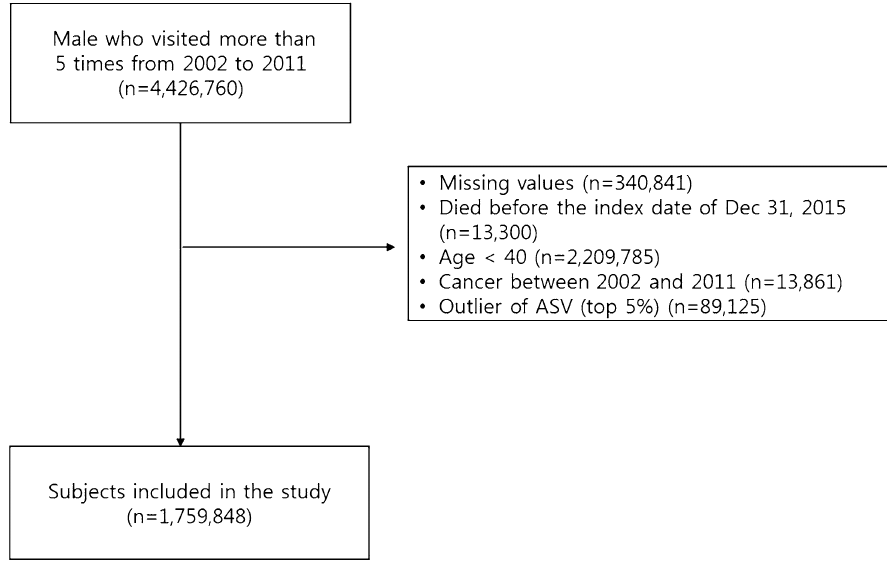
Figure 3. Flow diagram of the study